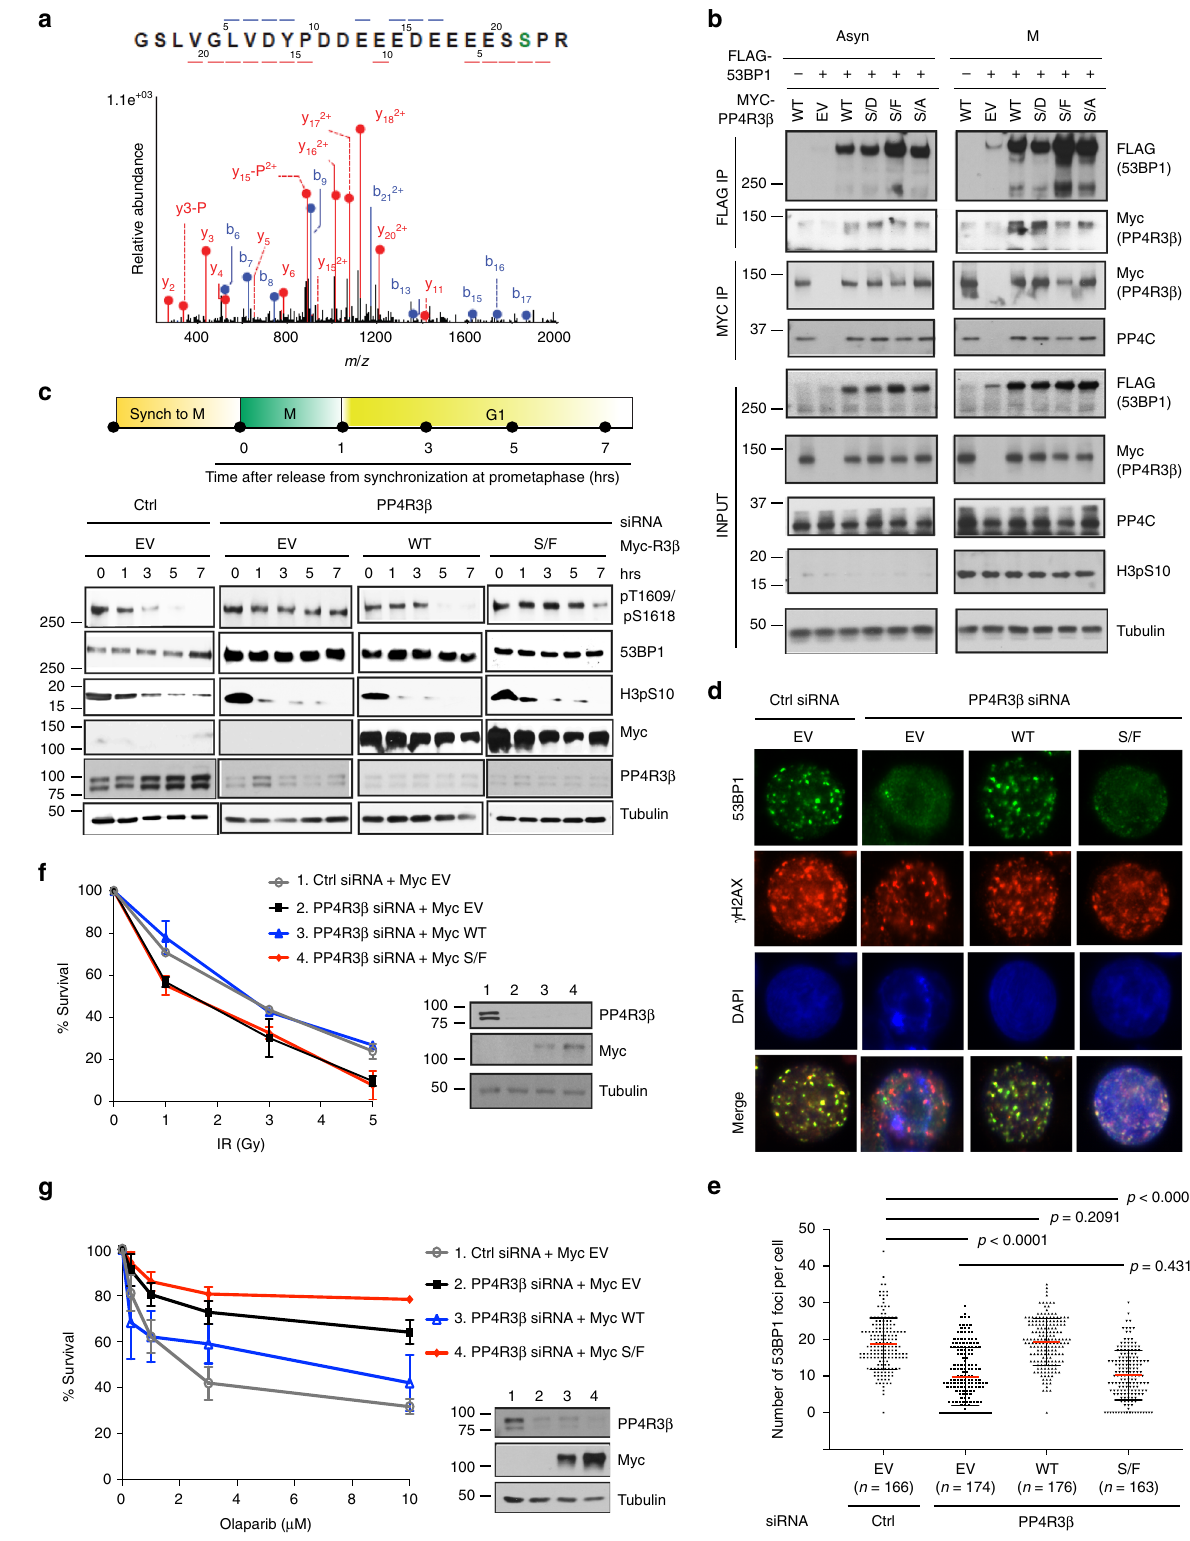
PP4R3 β S840 phosphorylation, we investigated the temporal correlation between 53BP1 phosphorylation at T1609/S1618 and PP4R3 β phosphorylation at S840 throughout mitosis. We synchronized cells to the G2/M border prior to mitotic entry using RO-3306 22 , and monitored the phosphorylation of these sites at distinct stages of mitosis after cells were released from